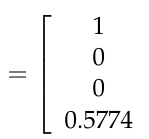
5  fault amplitude.